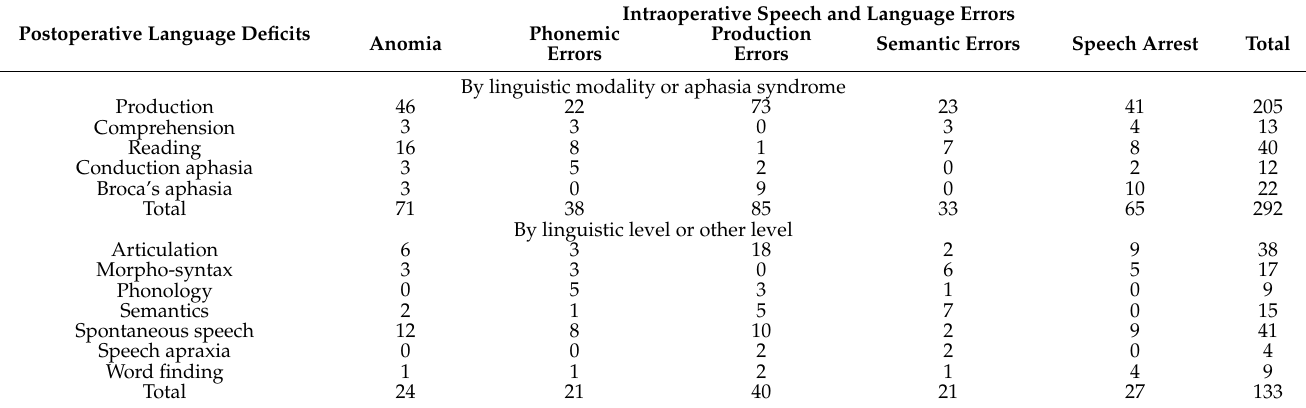
Table 6. The absolute frequencies of postoperative language deficits defined by linguistic modality or aphasia syndrome and linguistic level or other levelafter different intraoperative speech and language error